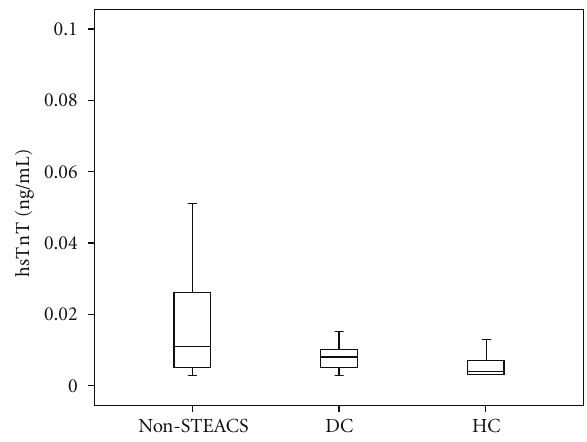
Figure 1: hsTnT levels in non-STEACS, stable coronary disease (disease controls) and healthy controls [values are median (IQR), and non-STEACS: non-ST elevation acute coronary s ´ ındrome, DC: disease controls, HC: healthy controls]. P < 0 . 001. [Values are median, IQR, and error